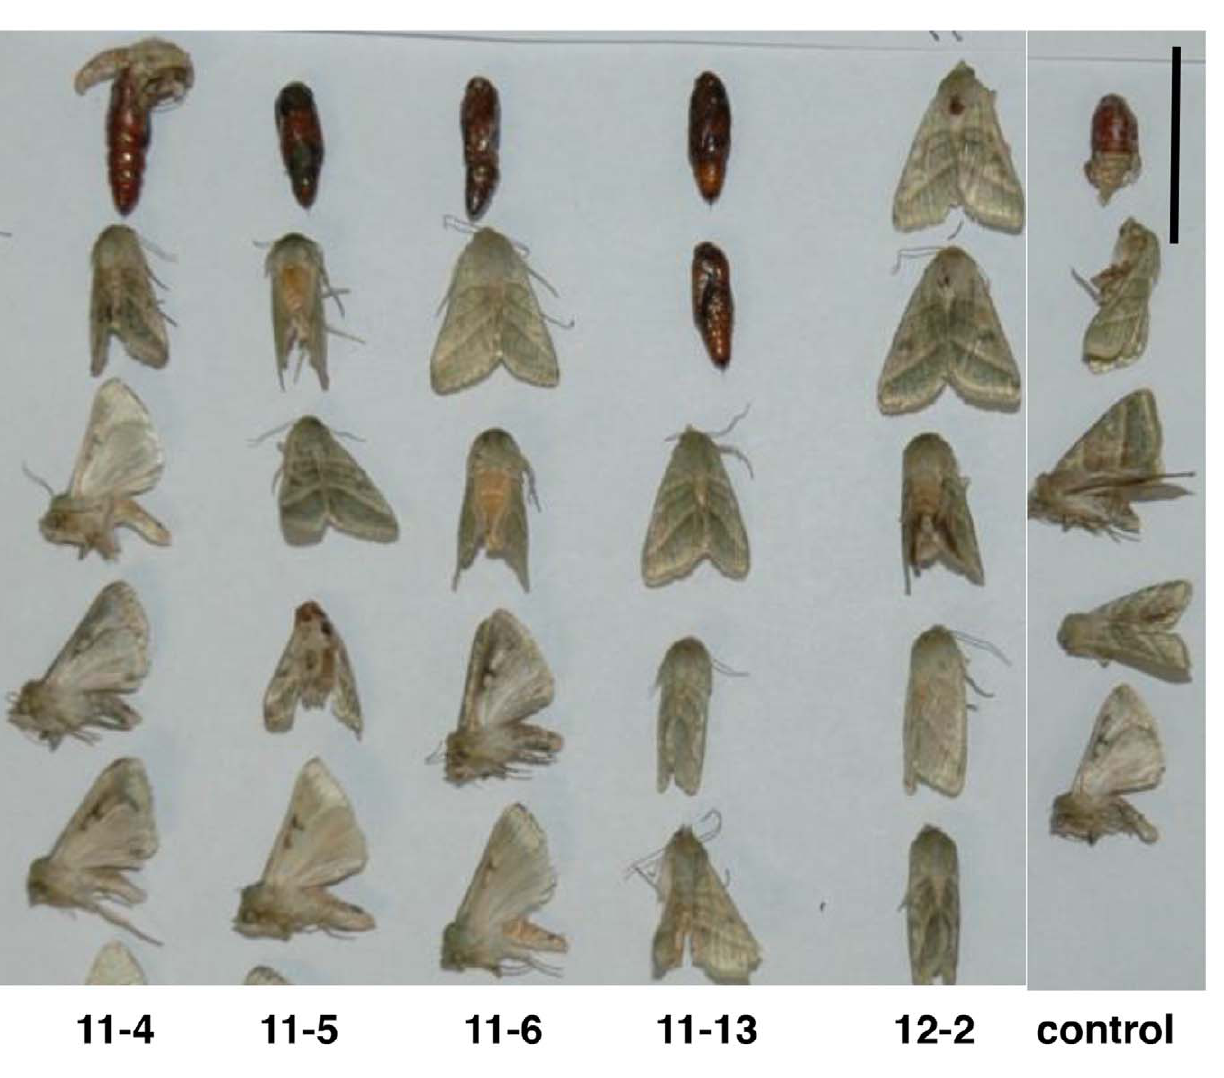
Figure 8. Tobacco budworm larvae and emerged moths from feeding bioassays on N.benthamiana plants transformed with the BvSTI gene. Transformant 11-4, 11-5, 11-6, 11-13 and 12-2 and untransformed normal control plant. Bar corresponds to 2 cm.